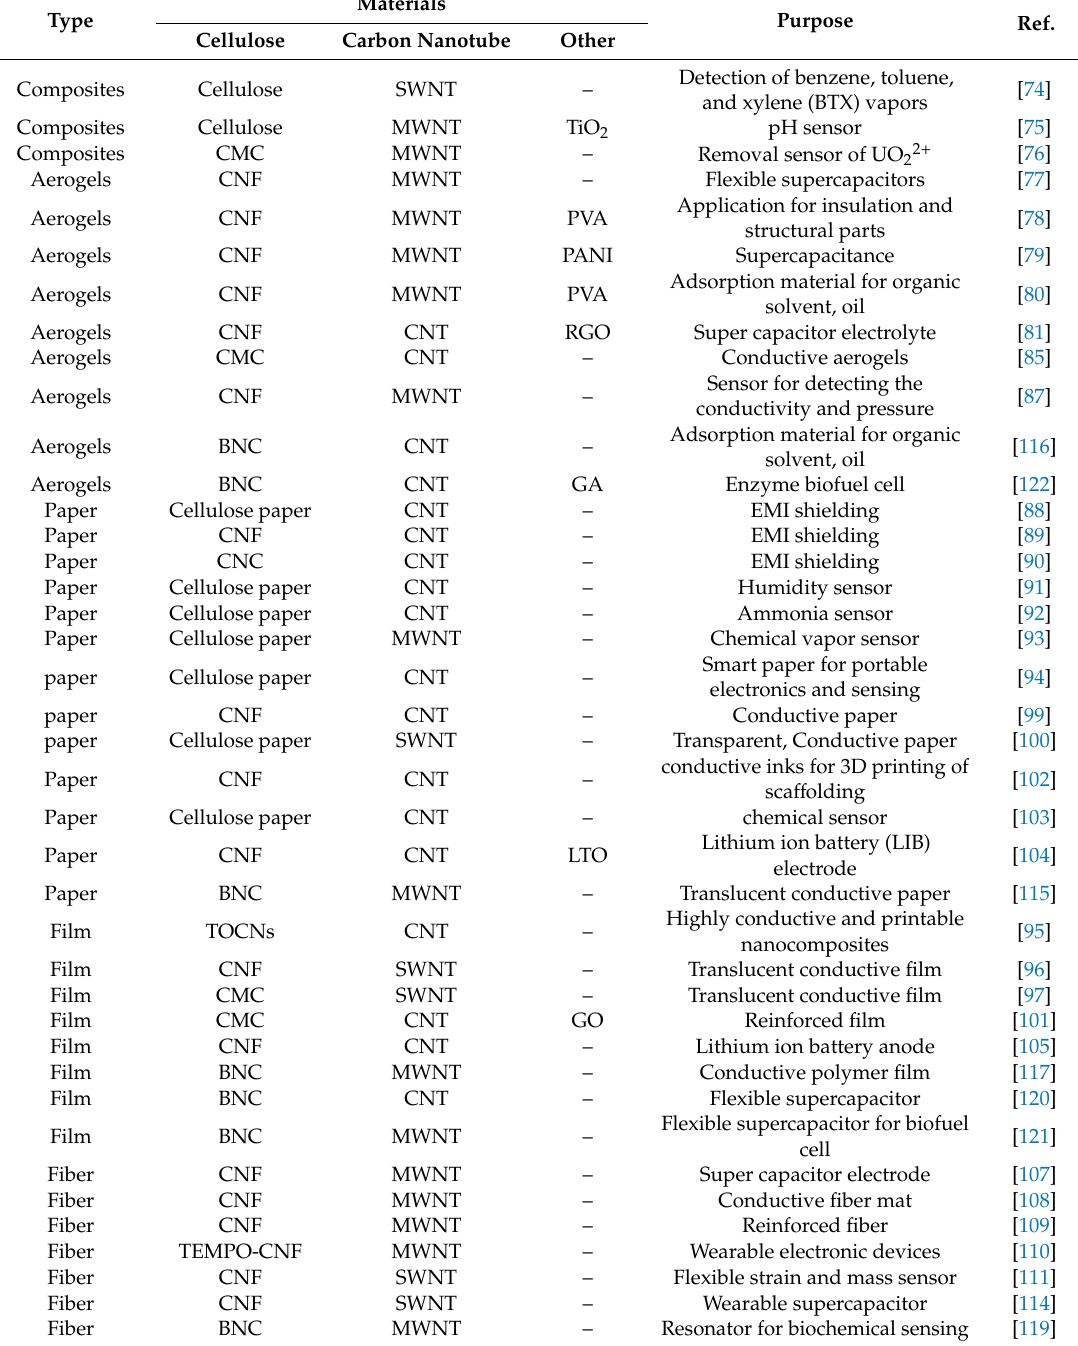
Table 3. Applications created by the combination of mixed cellulose and